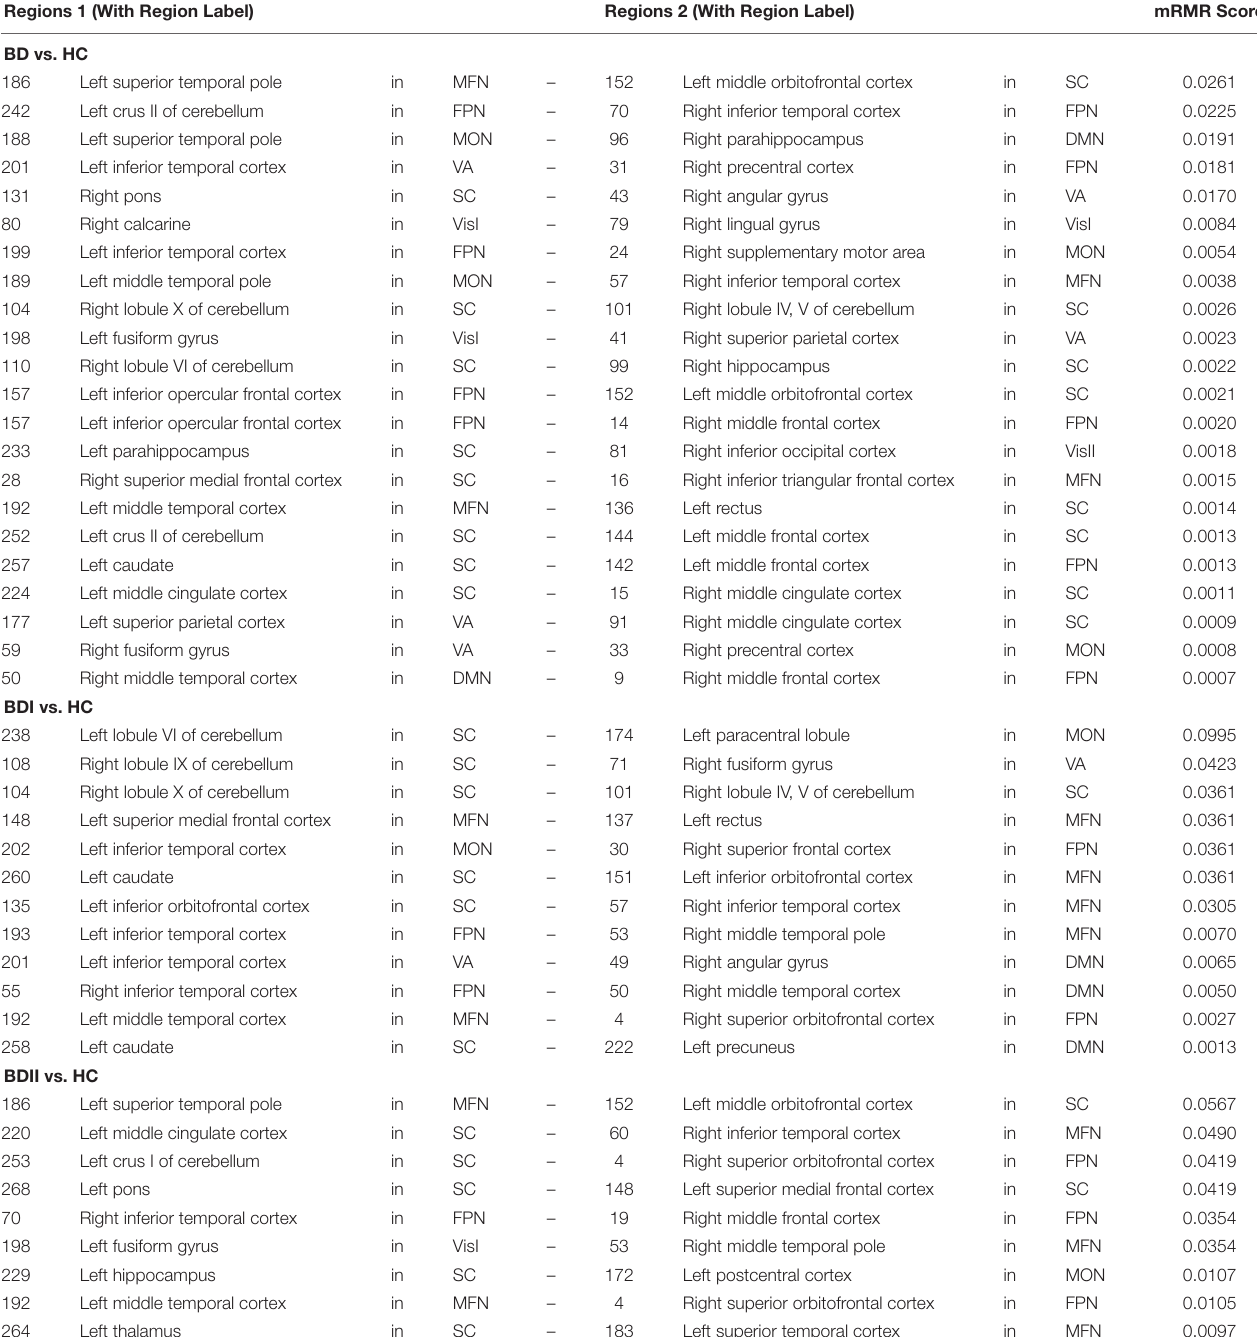
TABLE 3 | The major features after the 10 times process of minimum redundancy/maximum relevance selection. Regions 1 (With Region Label) Regions 2 (With Region